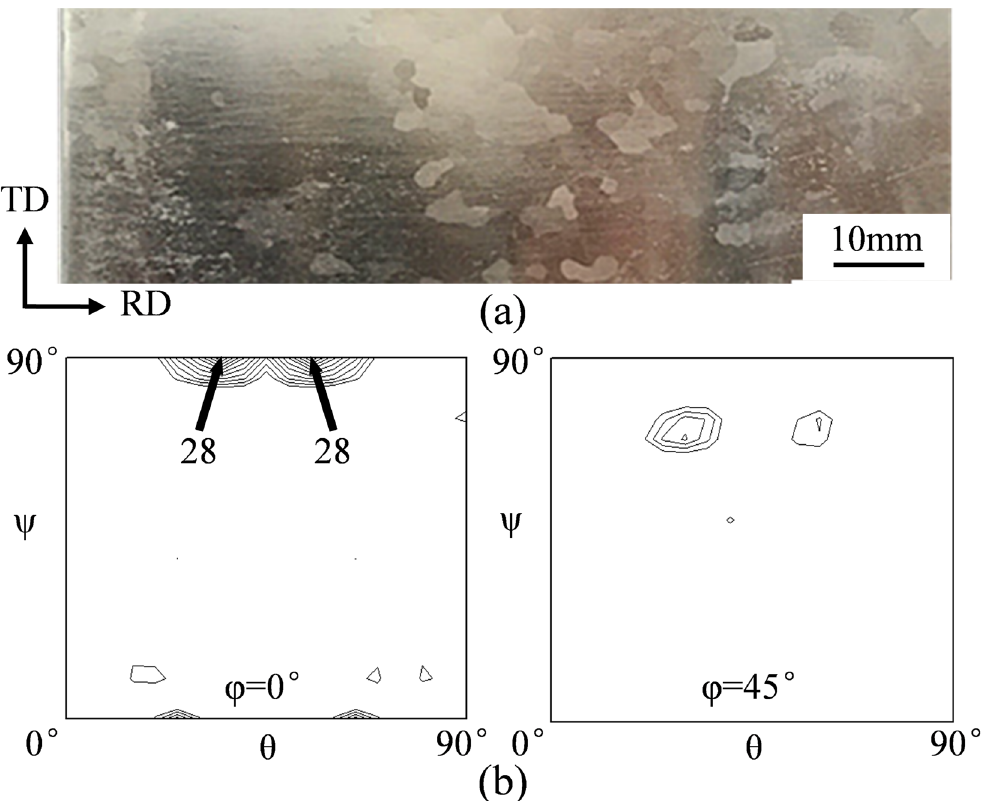
Figure 8. (a) Microstructure and (b) constant φ = 0° and 45° sections of ODFs (levels: 8, 10, 12...) of 83% warm rolled Fe-4.5 wt.% Si sheets after purification annealing at 1200 °C. {320}<001> for both sheets. And the {320}<001> weakens with the increase of reduction